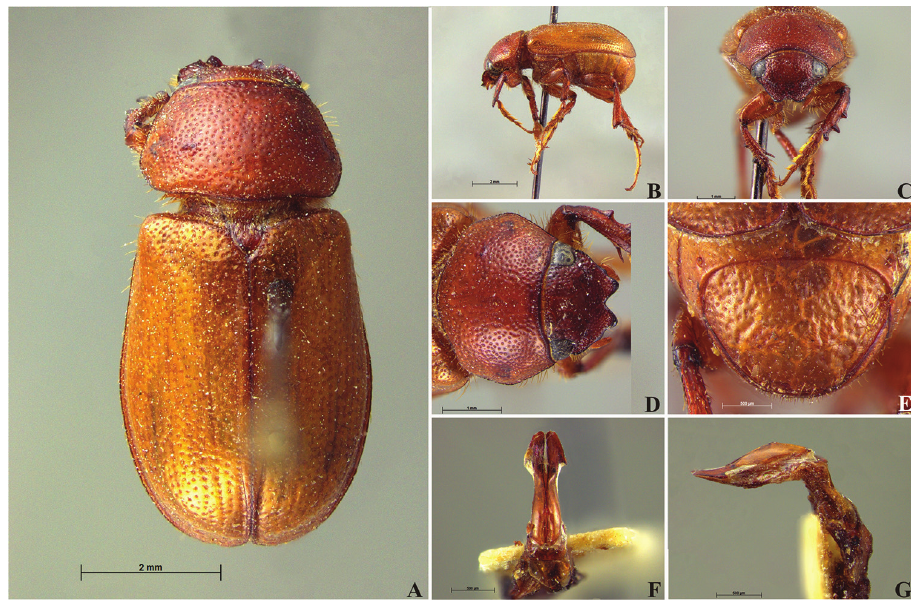
Figure 61. Liogenys corumbana Moser. A Dorsal view B Lateral view C Frontal view D Clypeus and pronotum E Pygidium F Parameres, dorsal view G Parameres, lateral